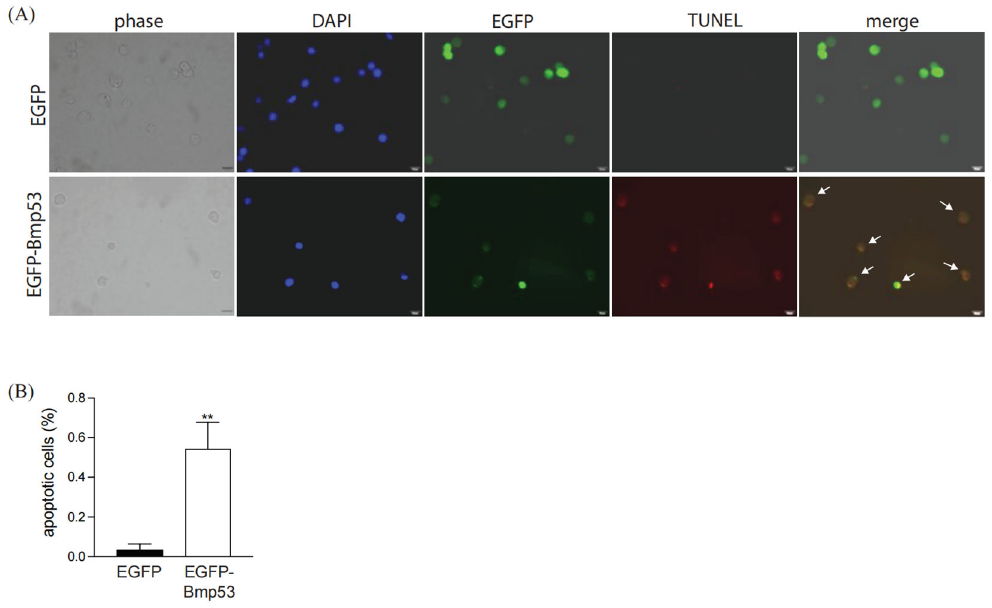
Figure 2. Increased cellular apoptosis in insect cells transiently expressing an EGFP-Bmp53 chimera. ( A ) BmN cells expressing the Bmp53 fusion protein were assayed for apoptosis using the TUNEL kit. Nuclei were counter-stained with DAPI (blue fluorescence). Co-localization of green (EGFP-Bmp53) and red fluorescence signals is indicated by the white arrows. Scale bar = 50 µ m. ( B ) The percentage of EGFP or EGFP-Bmp53 expressing cells that were positive for the apoptotic TUNEL signal. Statistical significance determined via student t -test ( ** p < 0.01) across three transfection replicates. Signals were determined for at least 12 EGFP-positive cells in each transfection experiment.